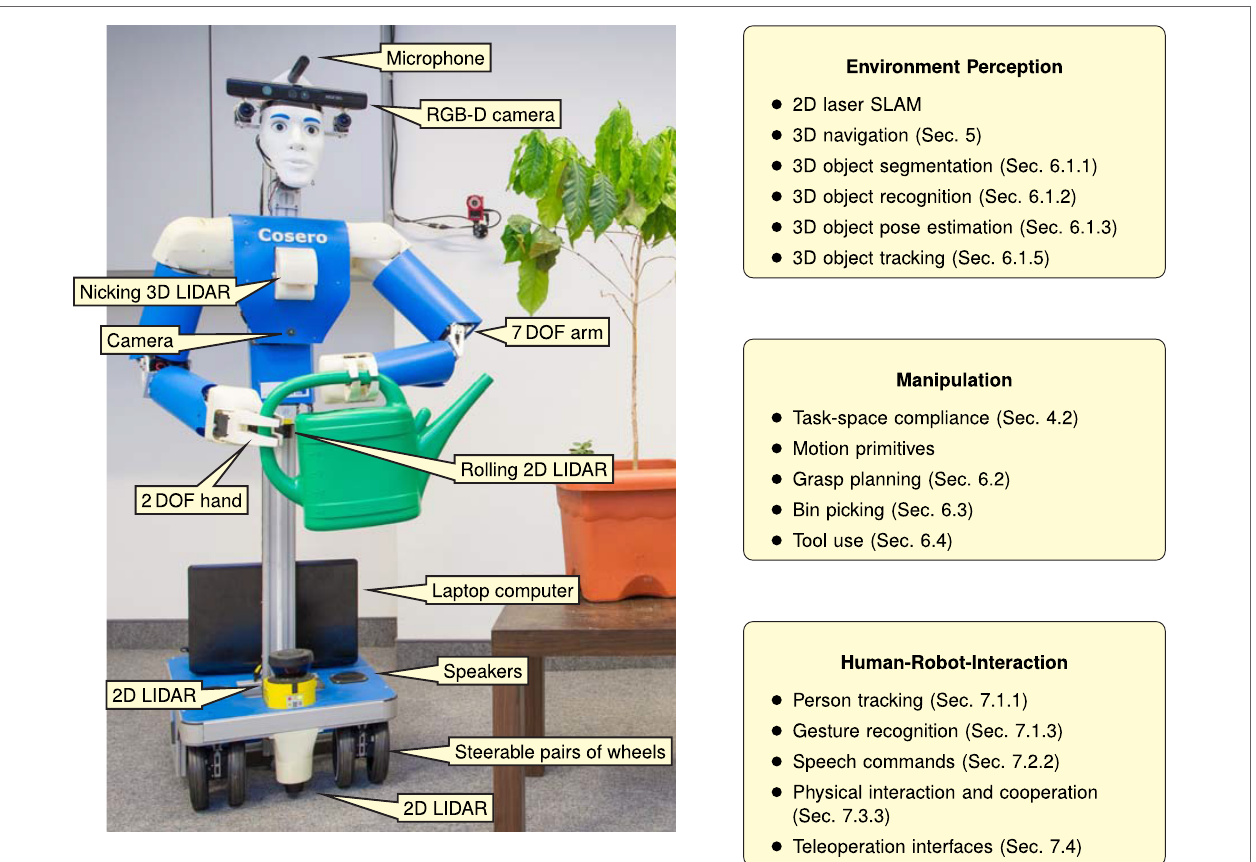
FIgURe 1 | overview of the cognitive service robot Cosero . The right column lists main capabilities of the system and references their corresponding sections in this